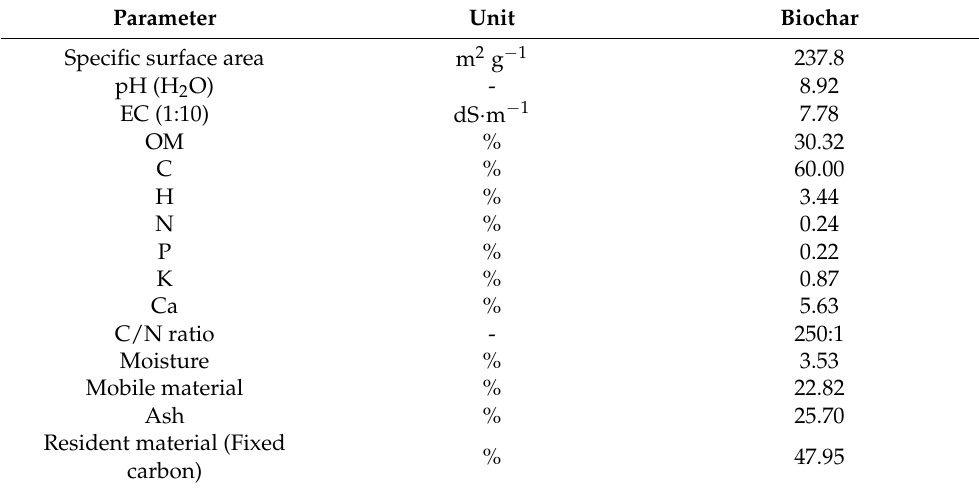
Table 2. Physico-chemical characteristics and proximate composition analysis of biochar.